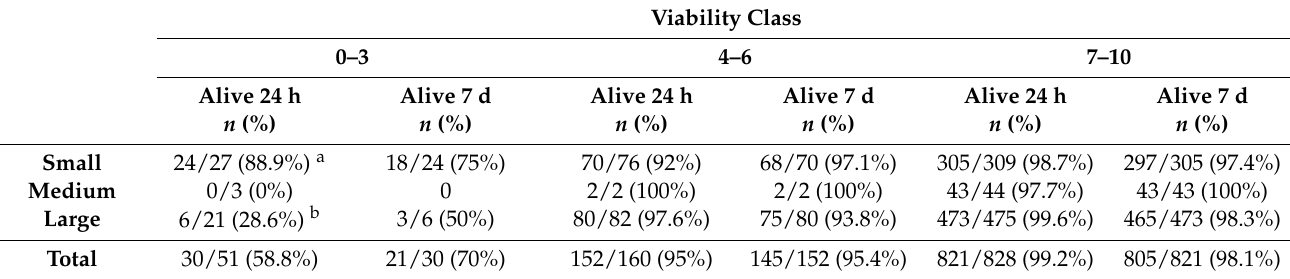
Table 8. Distribution (expressed as number and %) of newborn survival at 24 h and at 7 days (d) of age according to viability classification and to the